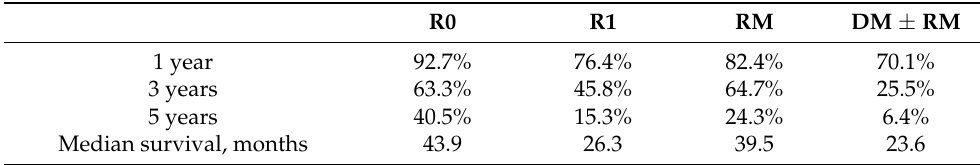
Table 3. Kaplan-Meier overall survival analysis.